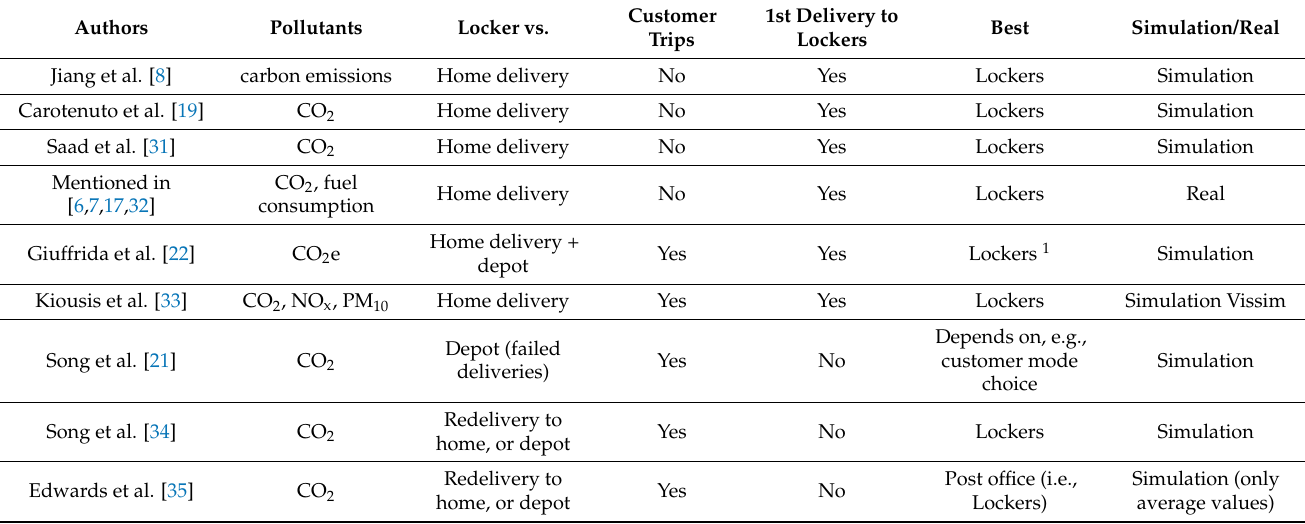
Table 1. Studies about emissions and parcel